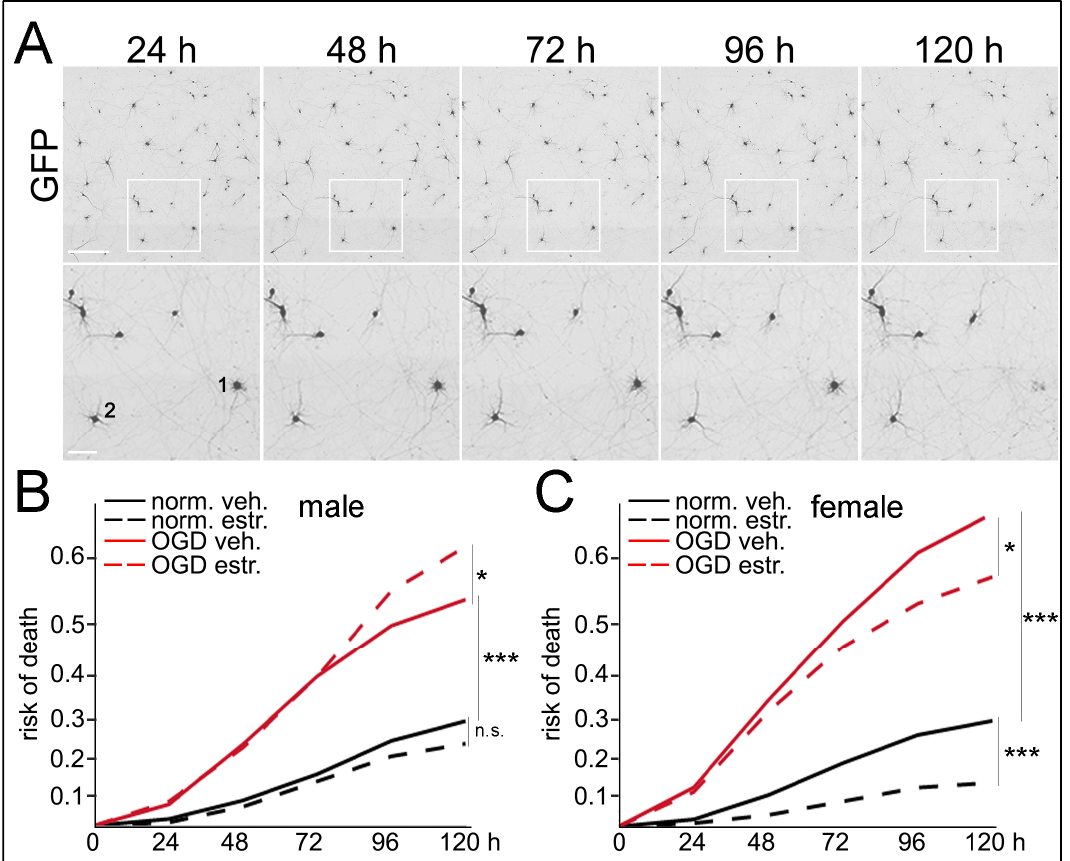
Figure 5. Sex differences in neuronal survival after E2 treatment and OGD/R. ( A ) The top panel is a representative figure of longitudinal imaging of the same group of neurons transfected with GFP (black and white images were color inverted to increase contrast). Scale bar, 400 µ m. The bottom panel shows zoomed in GFP-positive neurons that degenerate over time (i.e., neuron 1) or remain alive at the end of the experiment (i.e., neuron 2). Images were inverted and converted to black and white images to increase contrast of GFP-positive neurons. Scale bar, 50 µ m. ( B , C ) Cultured primary neurons from male ( B ) and female ( C ) embryonic rat pups were transfected with GFP at 4 DIV and let develop for 10 days. Survival graphs of male neurons ( B ) and female neurons ( C ), pre-treated with vehicle (veh.) or with 17 β -estradiol (E2) and subjected to normoxia (norm.) or oxygen and glucose deprivation (OGD/R) conditions. OGD/R significantly enhanced neuronal death in both sexes ( p = 0.0001). Neuroprotective effects of E2 under basal conditions was more evident for female neurons ( p = 0.0001) than male neurons ( p = 0.1508). E2 was also protective for female neurons ( p = 0.0268) after OGD/R, but not for male neurons. * p < 0.5, *** p < 0.0001, n.s., non-significant (log-rank test). One hundred neurons were analyzed per condition. Results were pooled from 5 male and 5 female embryonic (E20)